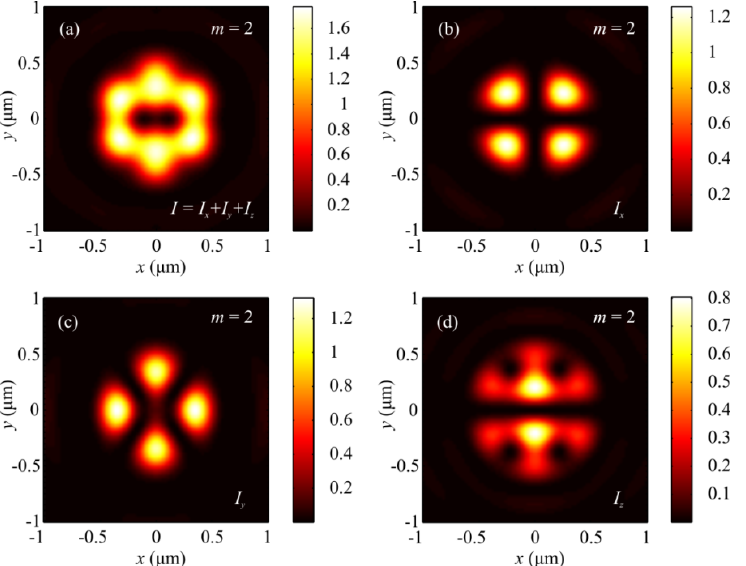
Figure 3. Patterns of ( a ) intensity and its components ( b ) I x , ( c ) I y , and ( d ) I z in the focal plane when focusing a plane wave with the hybrid polarization of Equation (1) at m = 2.